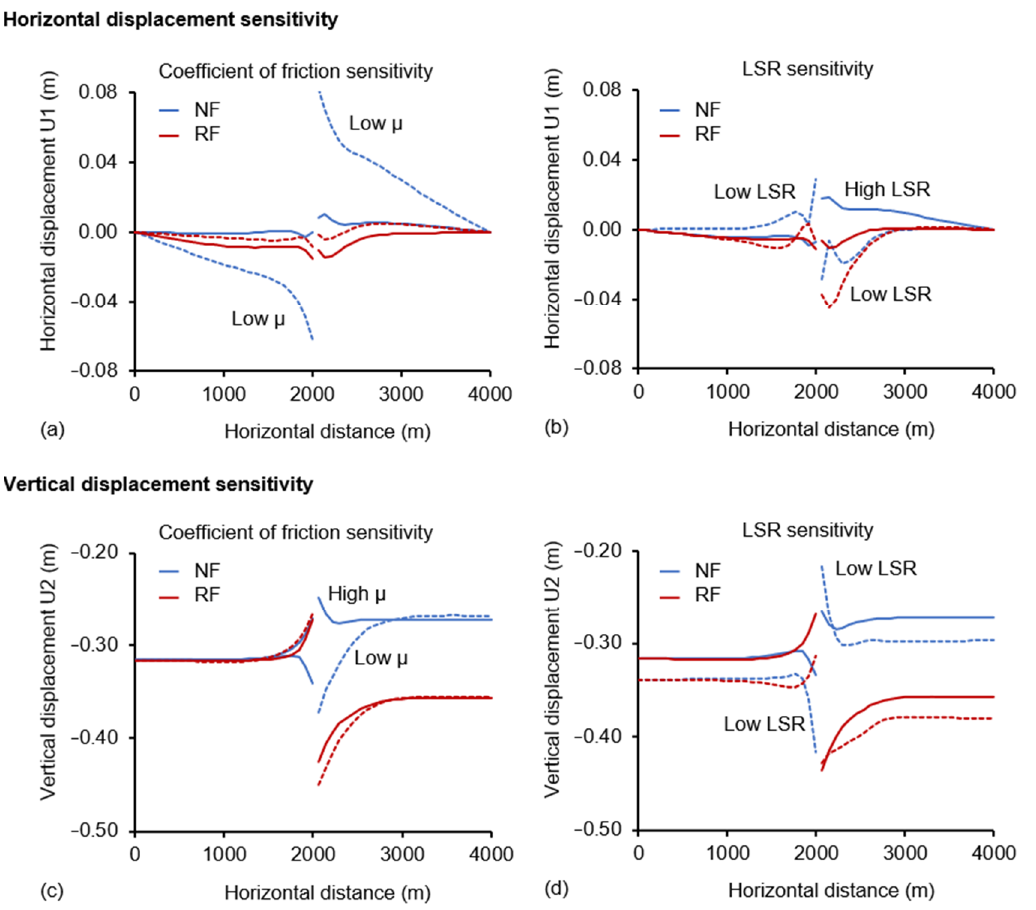
Figure 17. Displacement impact along the reservoir zones for normal and reverse fault geometries. The sensitivities include the μ change on the ( a , c ) and LSR change on the ( b , d ).